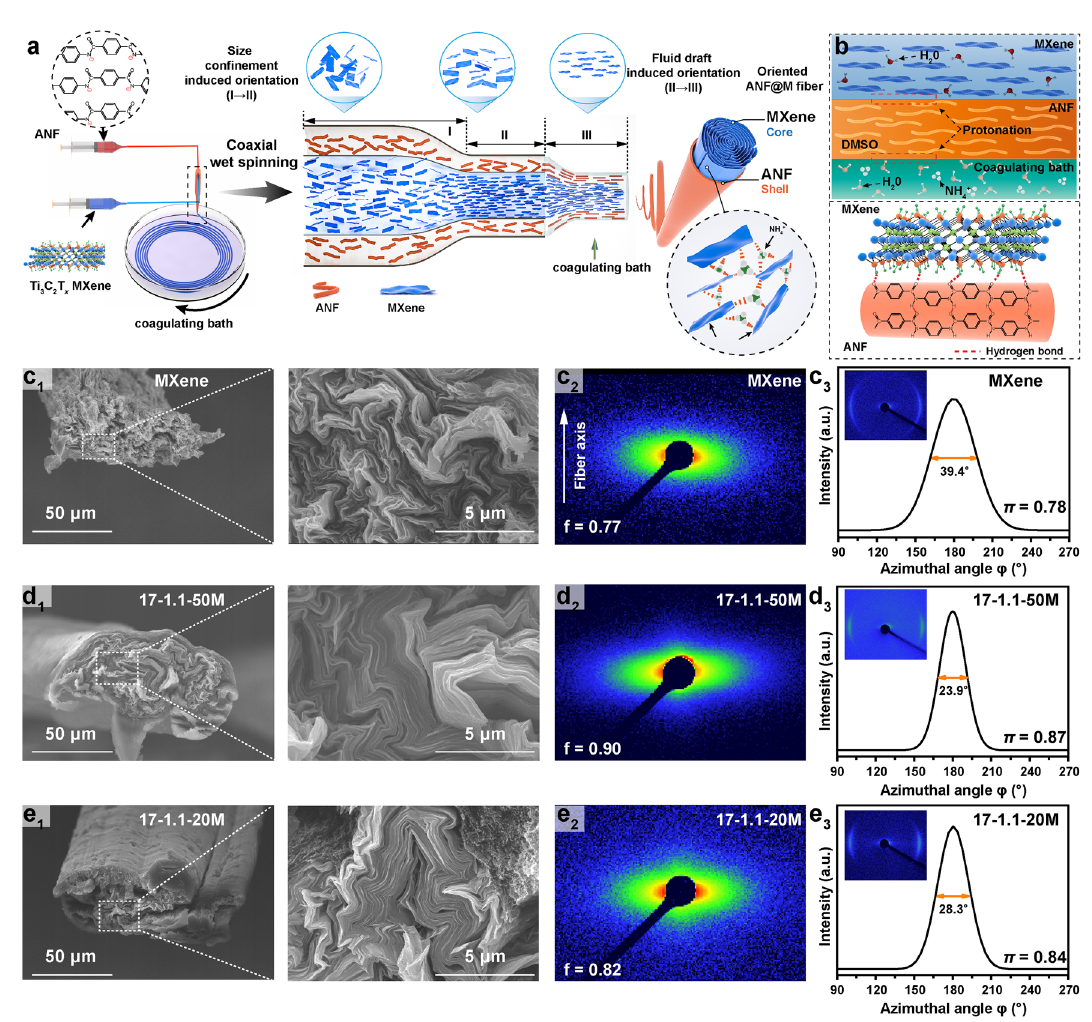
Fig. 1 a Schematic illustrating the fabrication of core–shell ANF@M fiber by coaxial wet spinning, the evolution of the sheet orientation, and the cross‑linking of MXene sheets with ammonium ions. b Protonation process of ANFs, and the interfacial interactions between MXene and ANF. c 1 , d 1 , e 1 Cross‑sectional SEM images, c 2 , d 2 , e 2 2D SAXS images, and c 3 , d 3 , e 3 2D WAXS images with corresponding fwhm curves for c MXene fiber, and d, e ANF@M